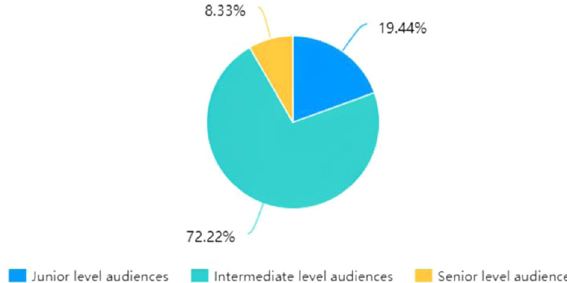
Fig. 3 Self-classi fi cation of audience type. This fi gure demonstrates the self-generated taxonomy based on the assumption that the audiences referring to subtitled settings could be classi fi ed as junior, intermediate and senior audiences according to their language competence (in English and Chinese, in this context), and their familiarity with the topic.